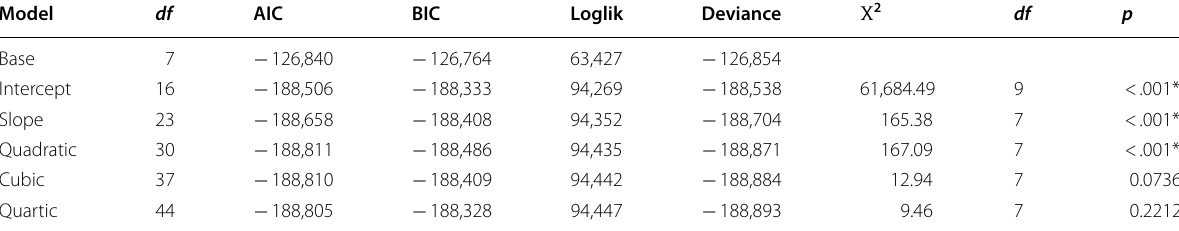
Table 2 Maximum likelihood model comparison in E1